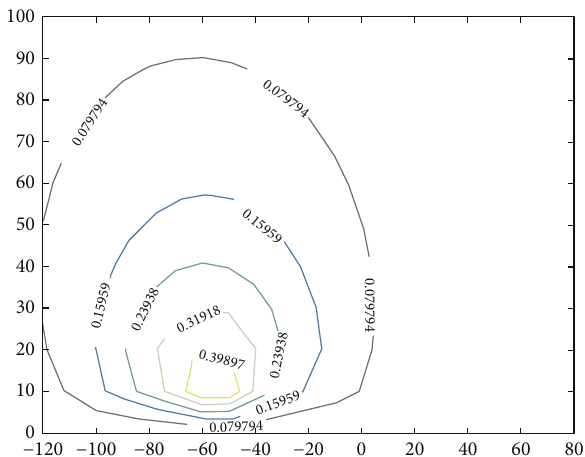
Figure 8: Contours of shear stress variation distribution of overlying strata. (The abscissa is the dip direction of the working face, the ordinate is the height, and − 60m is the position of the working